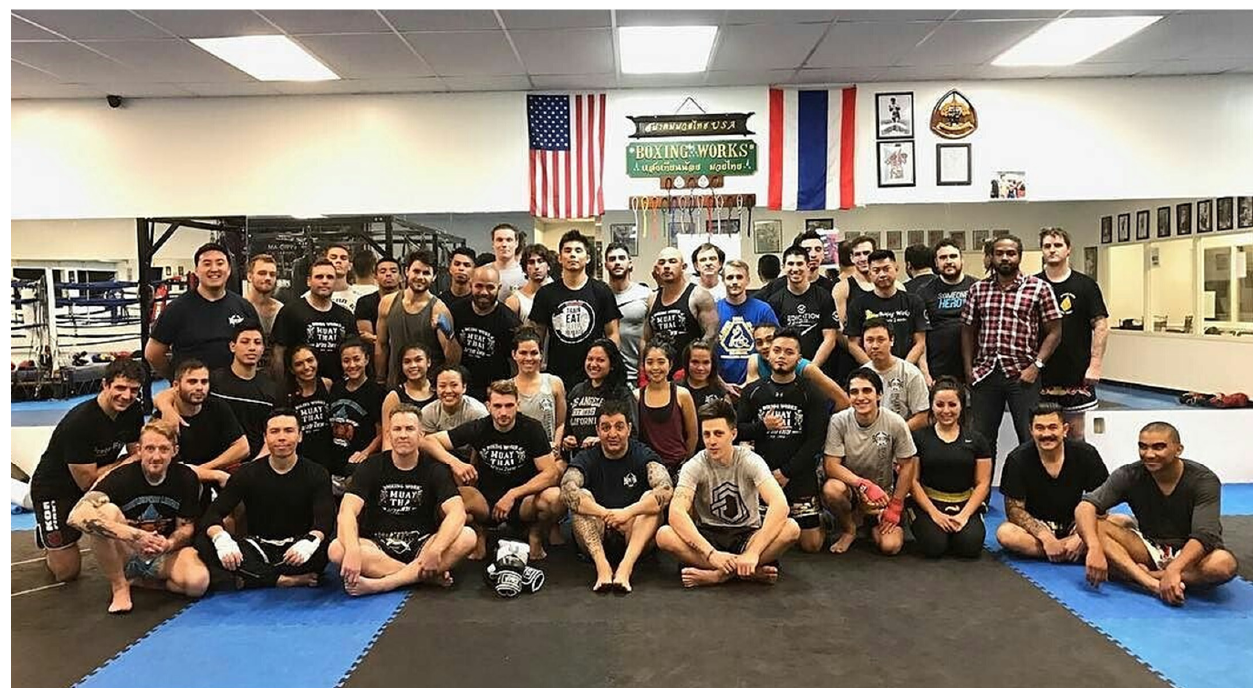
Figure 4. Muay Thai training can contribute to social relationships. Individuals across cultures, professions, religions, political affiliations, and socioeconomic statuses are united by the common goals of improving fitness and developing mastery in martial arts skill. Photo with Kru Bryan Popejoy and the Boxing Works familia in Redondo Beach, California.